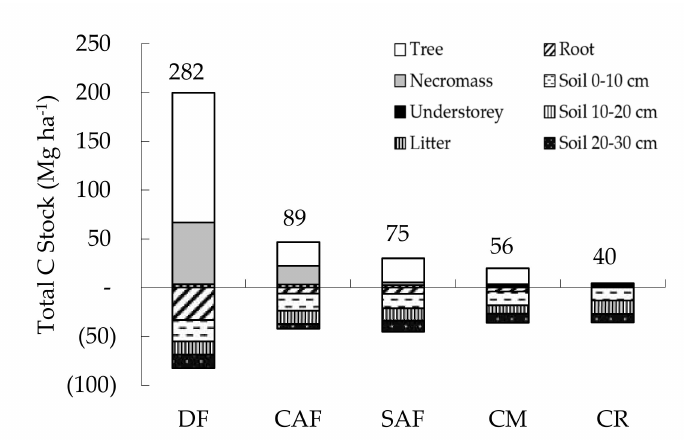
Figure 3. Total carbon stock in cacao-based agroforestry systems in 5 C pools compared to degraded forest and annual crop systems (DF = Degraded forest; CAF = Cacao complex agroforestry; SAF = Cacao simple agroforestry; CM = Cacao monoculture; CR = Annual